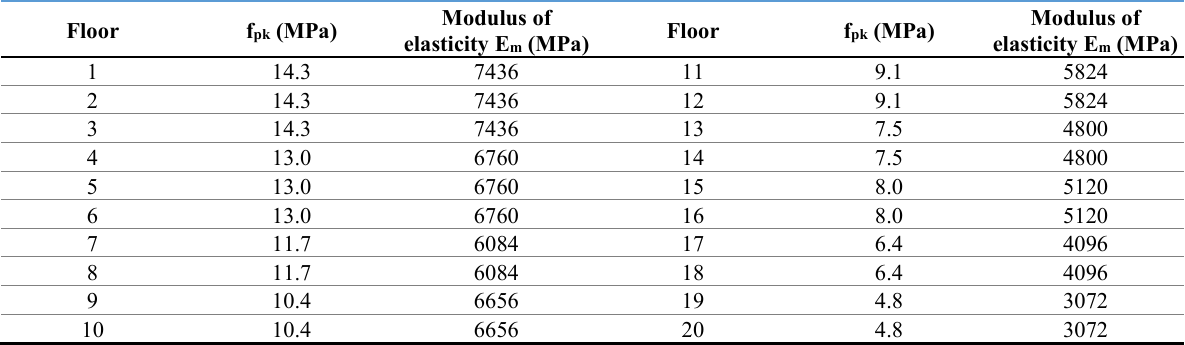
Table 2. Longitudinal modulus of elasticity of flexible bars per